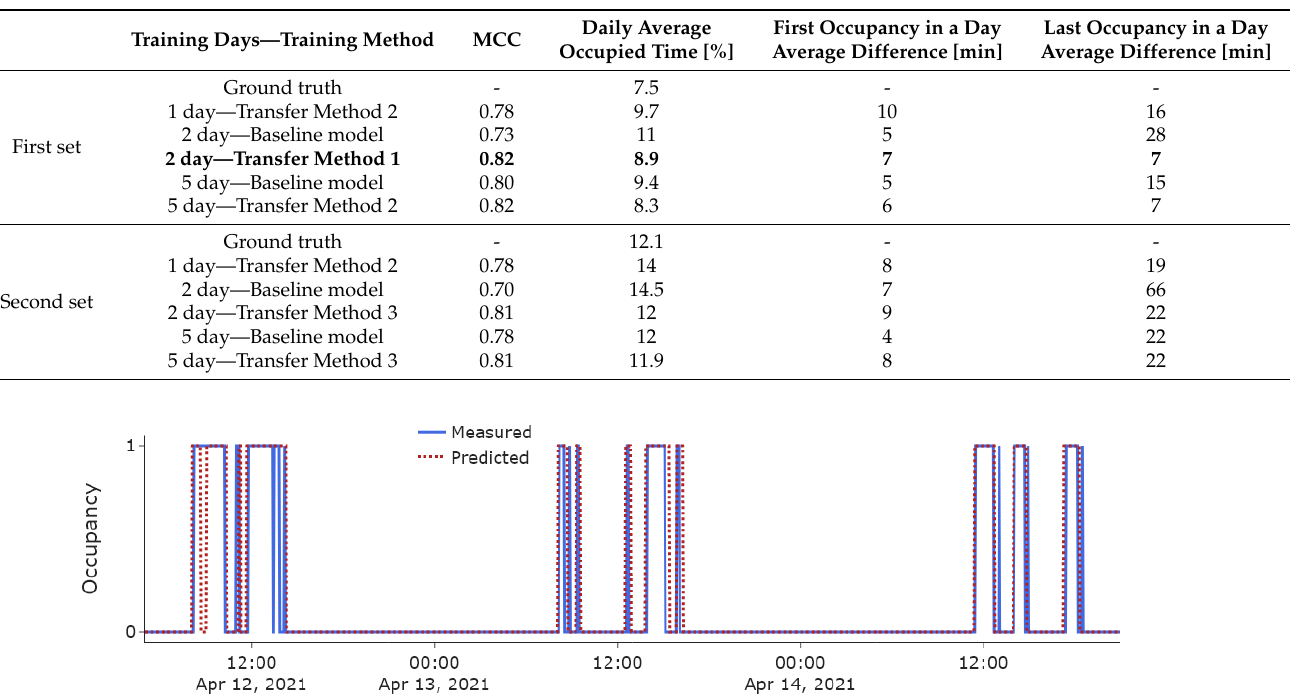
Table 4. Additional performance metrics for selected models of different training length and method.